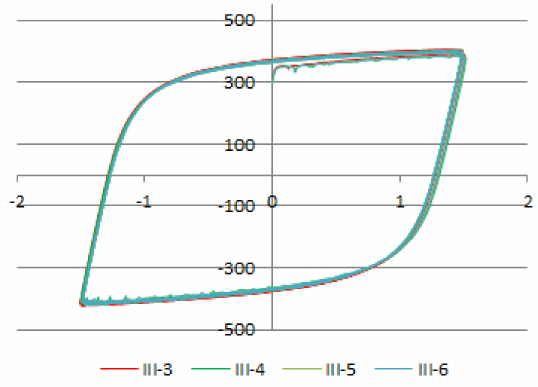
Figure 16. A comparison of hysteresis loops of the same amplitudes ε = ± 1.5, formed at different load